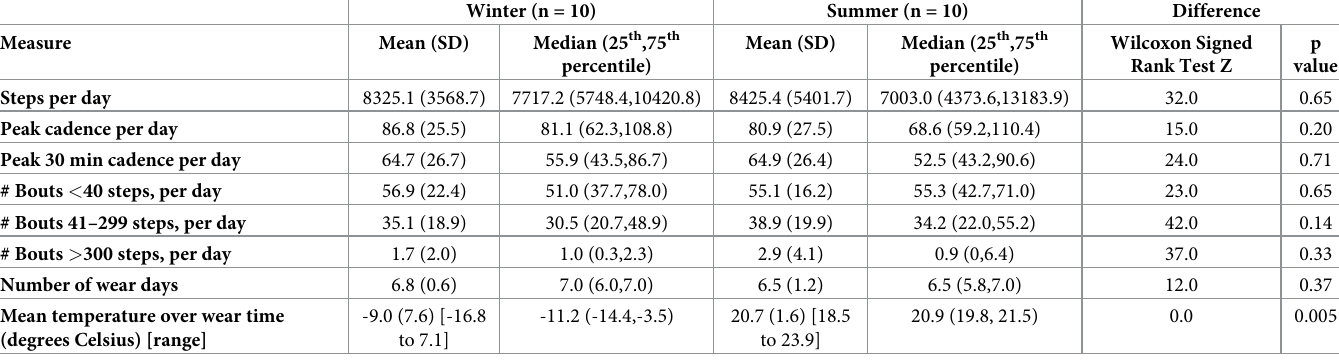
Table 5. Activity monitor outcomes by